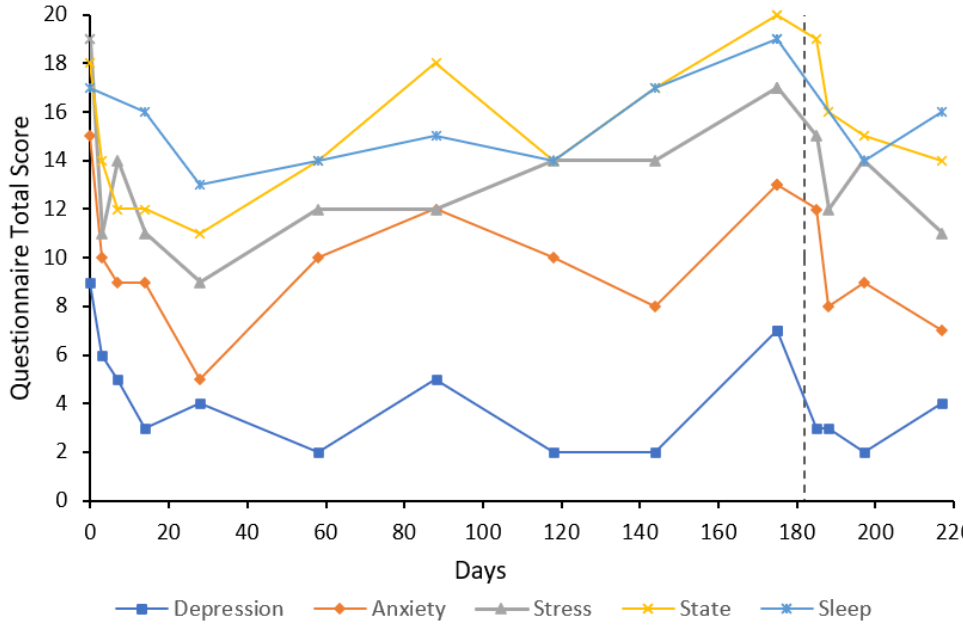
Figure 5. Line graph showing Case 5 results from the DASS-21 (depression, anxiety, and stress subscales), SSAI-6, and JSS at each follow-up. The participant was treated with an eight-day flumazenil infusion and re-treated on day 182 with an eight-day flumazenil infusion (denoted by a dashed line).